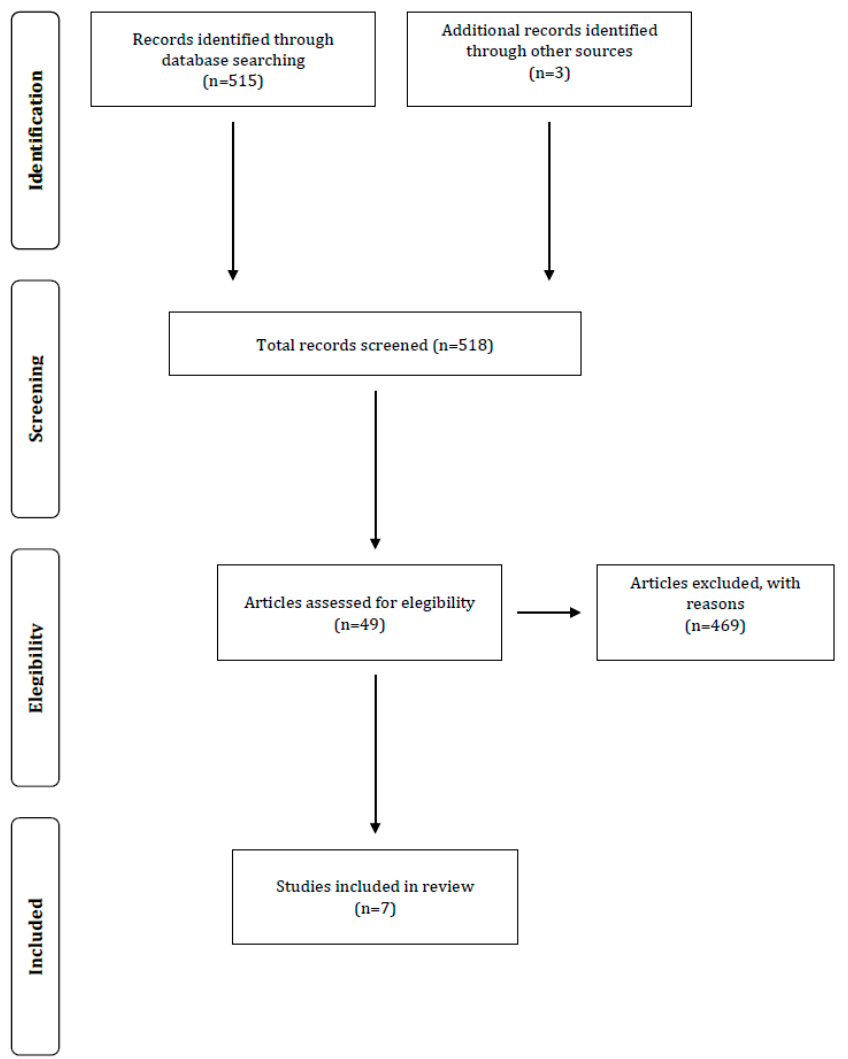
Figure 1: Flow diagram of search process. Figure 1. Flow diagram of search